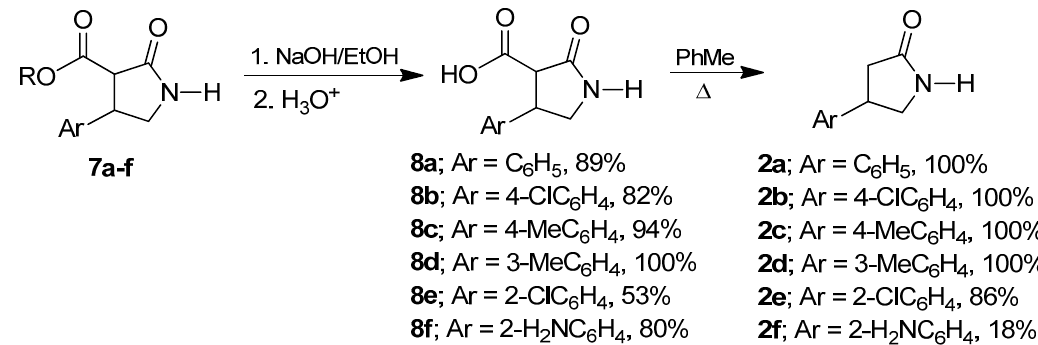
Scheme 3. Preparation of racemic γ -lactams ( 2a – f ).